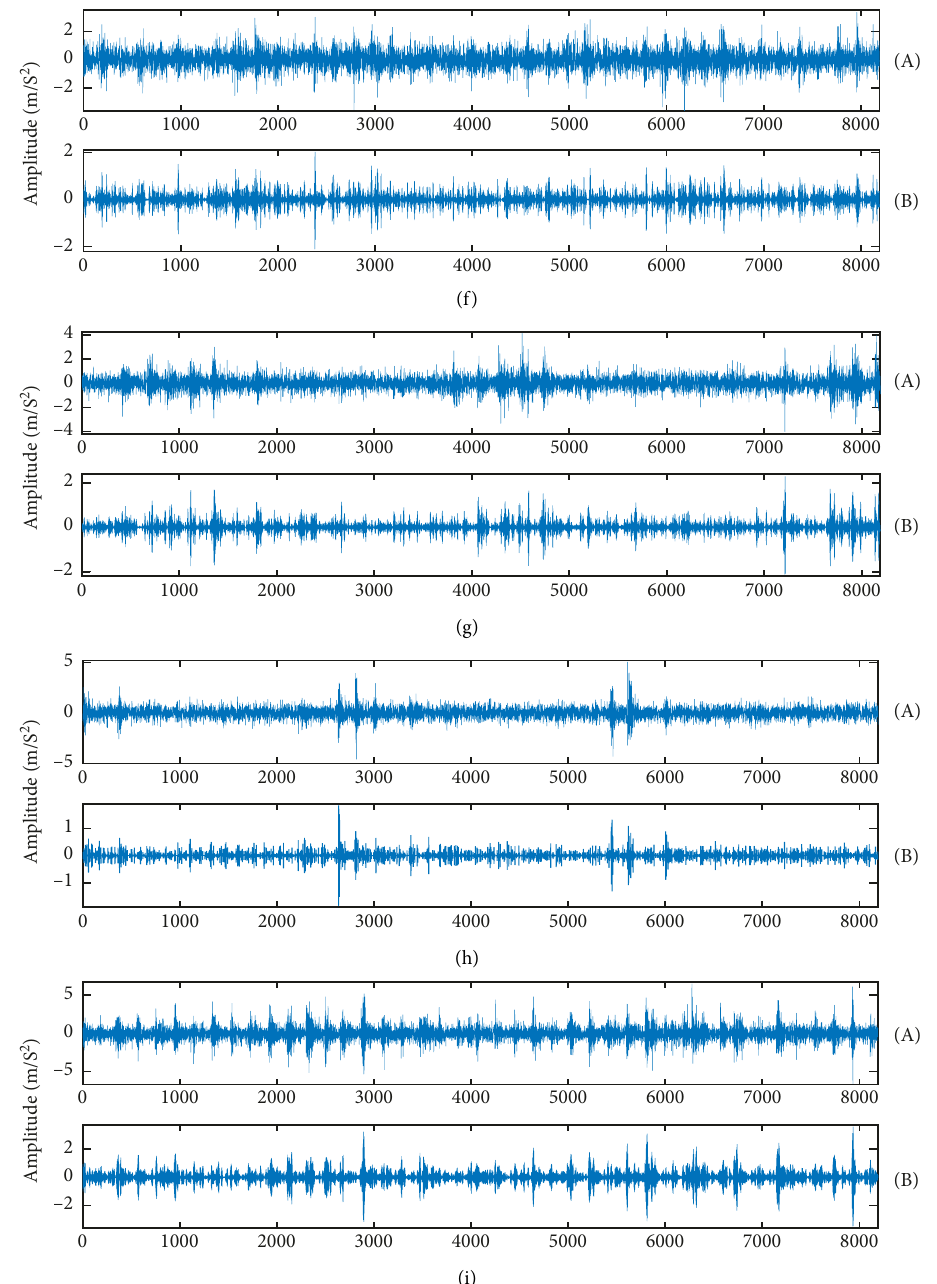
Figure 9: The noisy signals and the denoised signals of the nine conditions. (A) Noisy signals. (B) Denoised